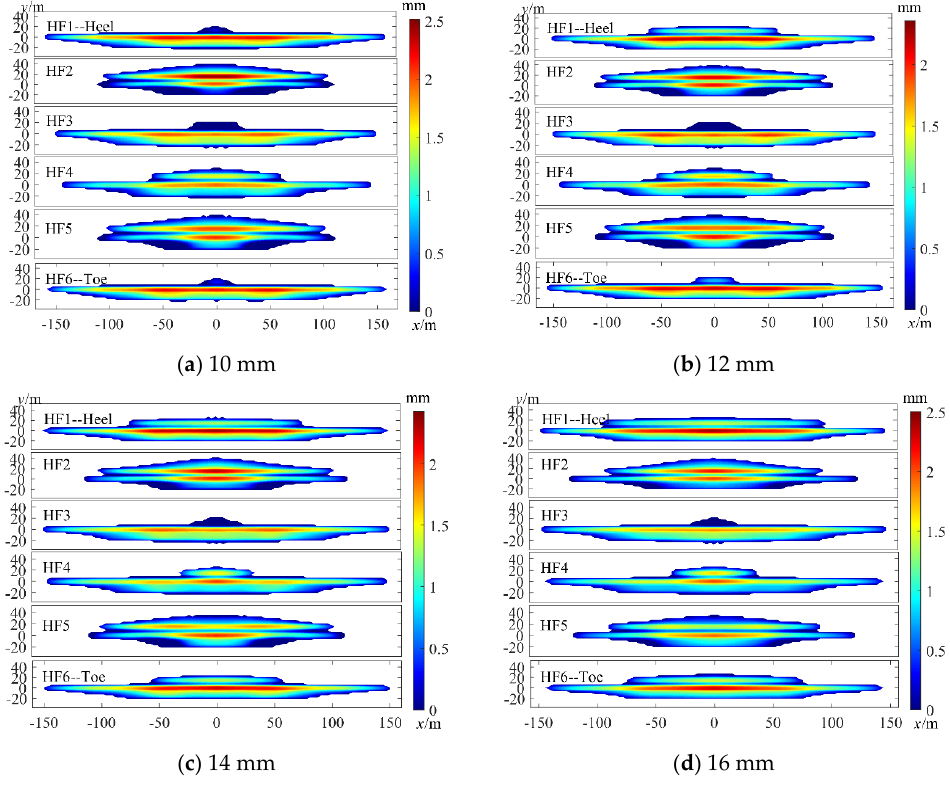
Figure 8. Patterns of fractures at different perforation diameters.